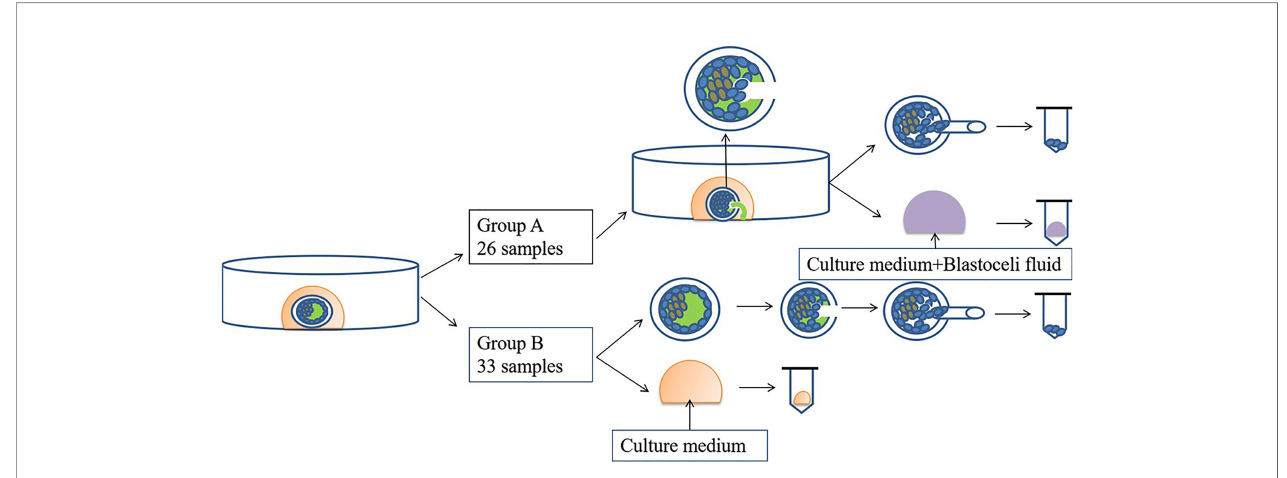
FIGURE 1 | Flow diagram of this